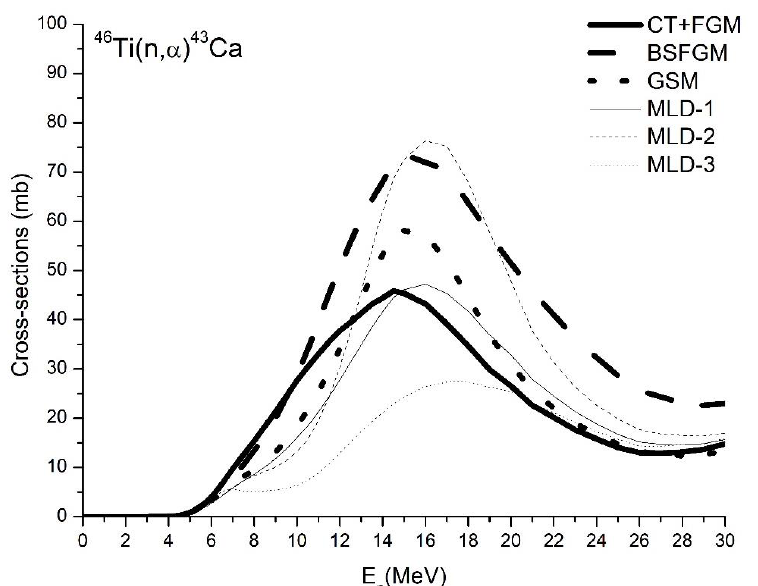
Figure 1: The theoretically calculated excitation functions for 46 Ti (n, α) 43 Ca